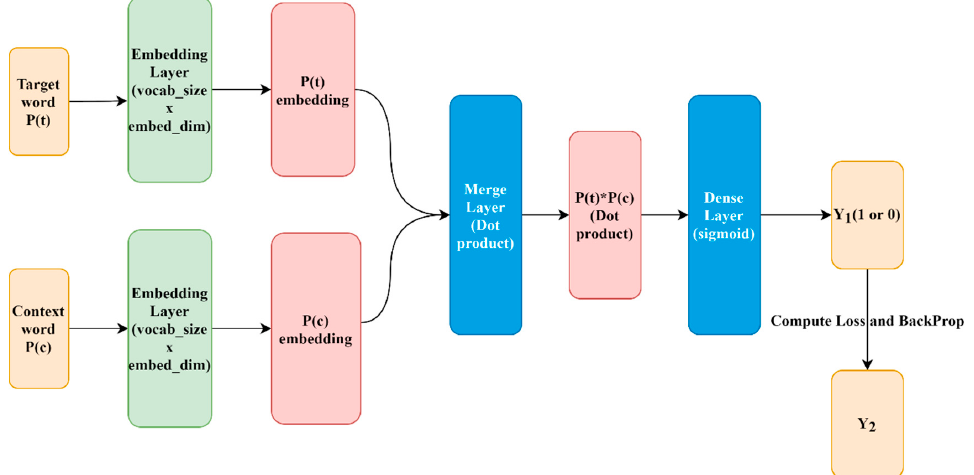
Figure 1. The structure of Skip-gram model.